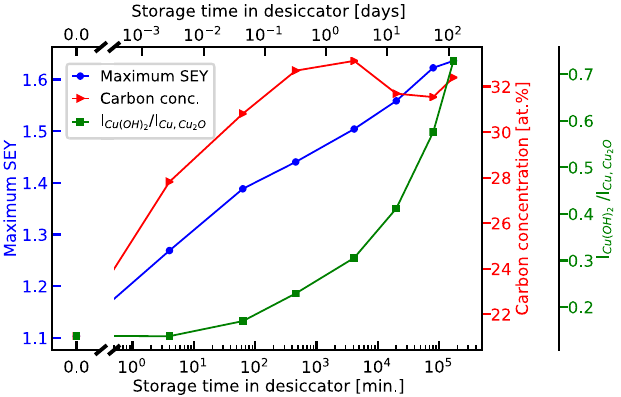
FIG. 4. Evolution of the maximum SEY, atomic surface =I concentration of carbon and ratio I over storage Cu ð OH Þ 2 Cu ; Cu 2 O time in a desiccator after full conditioning. The time t ¼ 0 corresponds to the fully conditioned state, just before venting, and the three data points for the maximum SEY, carbon =I concentration, and I overlap there. Cu ð OH Þ 2 Cu ; Cu 2 O